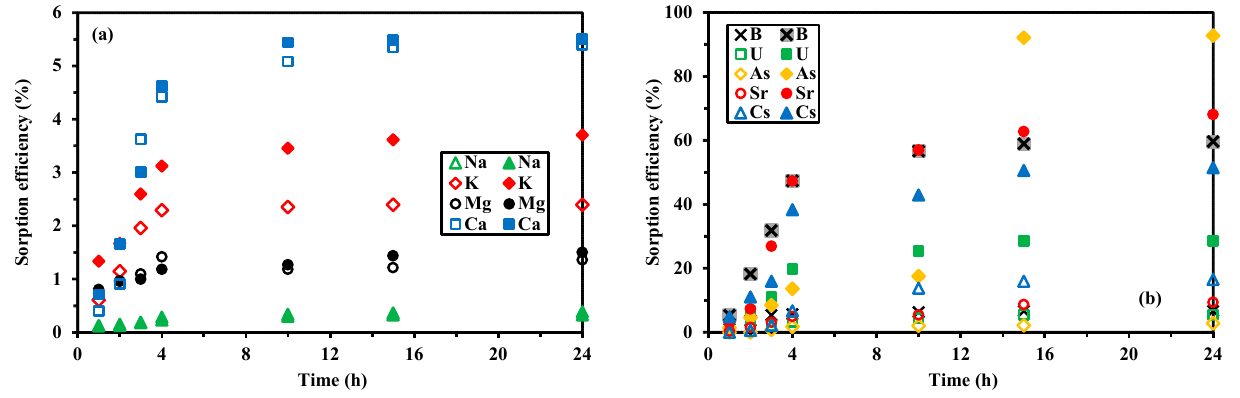
Figure A21. Time evolution of sorption efficiency for major elements ( a ) and trace elements ( b ) using ALG-PEI (empty symbols) and APO-PEI (filled symbols) sorbents (initial concentrations see Table